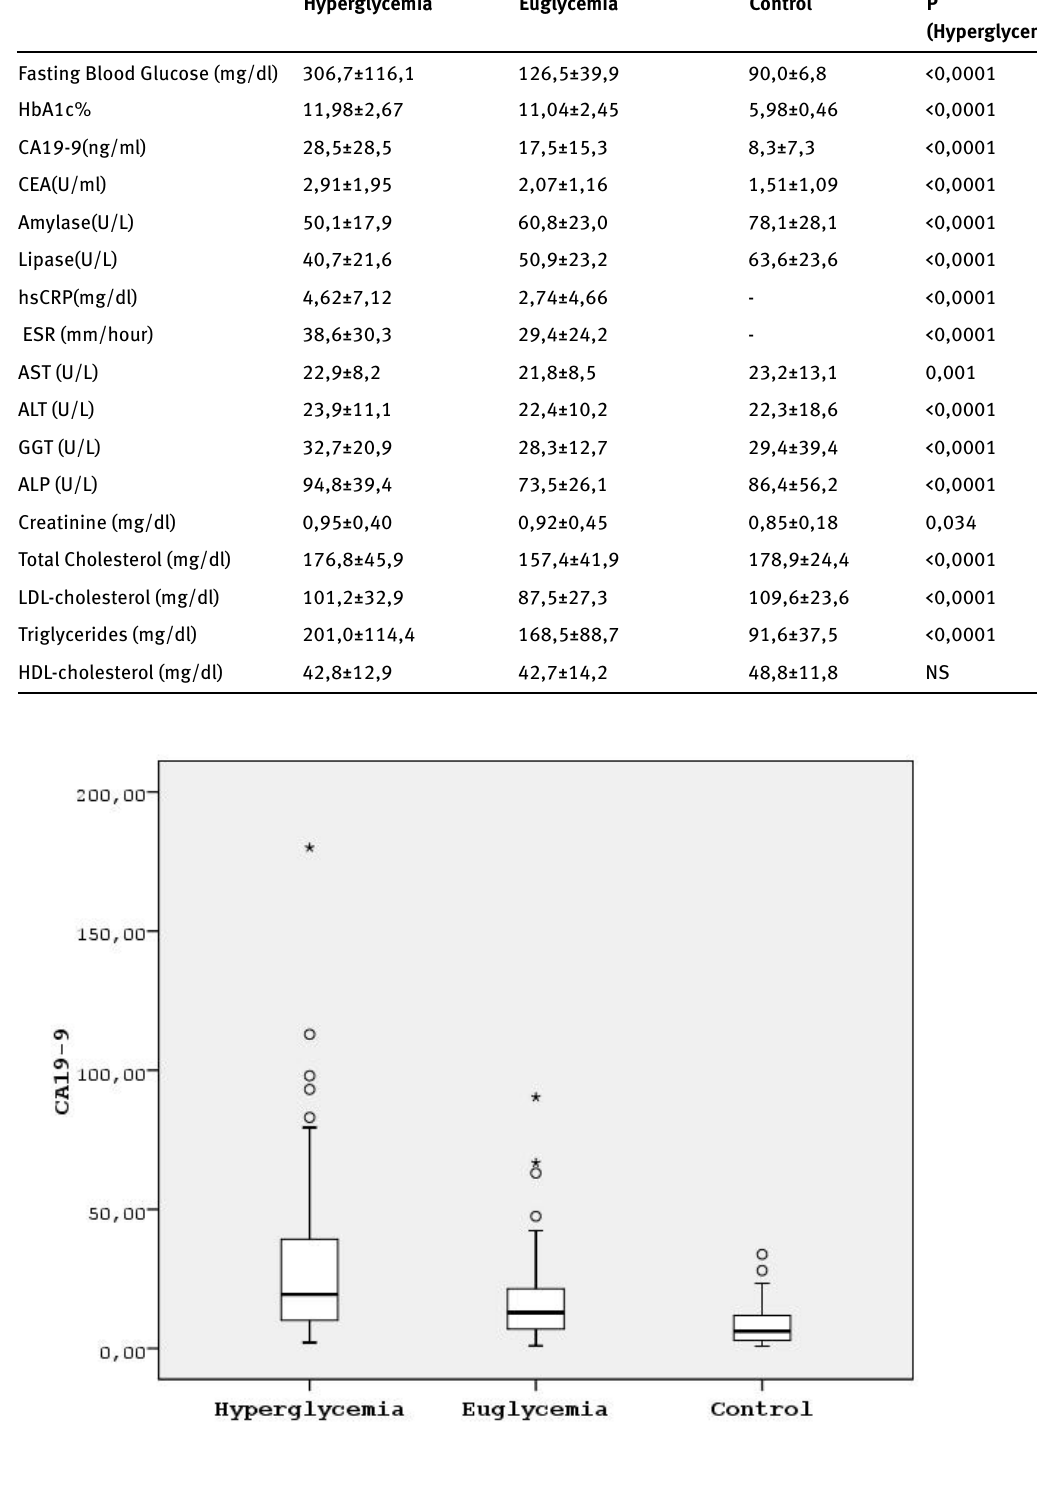
Hyperglycemia Control P